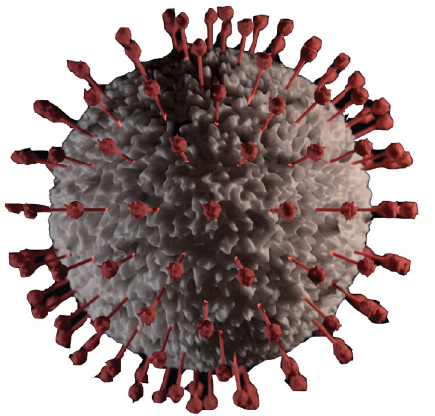
Figure 1: COVID-19